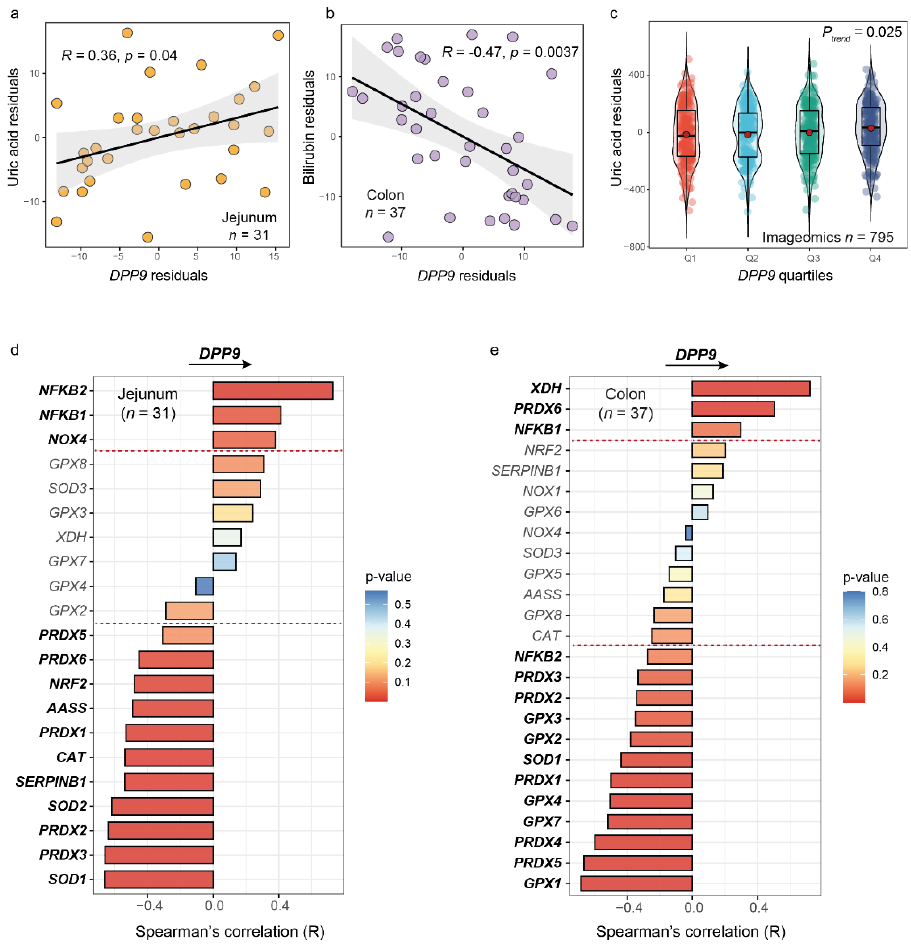
Figure 2. Associations of biomarkers and genes involved in antioxidant defense and oxidative stress with the expression levels of DPP9 in jejunum and colon. Scatter plot of the partial Spearman’s rank correlation (adjusting for age, se x, and BMI) between ( a ) circulating uric acid and the DPP9 expression in the jejunum, ( b ) plasma bilirubin and the DPP9 expression in the colon. ( c ) Violin plot of the circulating uric acid levels and the quartiles of the DPP9 expression in blood in the Imageomics cohort (adjusted for age, sex, and BMI). ( d ) Barplot of the Spearman’s correlations of antioxidant and ROS-generating genes with the expression of DPP9 in the jejunum and ( e ) colon. Bars are coloured according to the p-value. Genes above and below the read linies are significant after correcting for multiple comparisons with the Benjamini-Hochberg false discovery rate correction. 3.2. Genes Associated to DPP9 Expression in the Colon Are Involved in Viral Replication, Antiviral Mechanisms and Metabolism of Nucleotides We next sought to identify co-expression patterns of genes associated with DPP9 from the colon microarray. Using Spearman’s ran k correlation analyses adjusting p -values with the Benjamini-Hochberg correction, we identified 605 out of 21,571 genes significantly associated (P-FDR < 1 × 10 − 4 ) with DPP9, 419 positively and 186 negatively (Table S3). To gain a better insight into the functional pathways involved in these associations we performed an enrichment analysis based on Reactome gene sets using Metascape. Functional enrichment analyses of colonic genes that were significantly associated with the DPP9 expression highlighted an over-representation of 100 pathways (Figure 3a, Table S4).